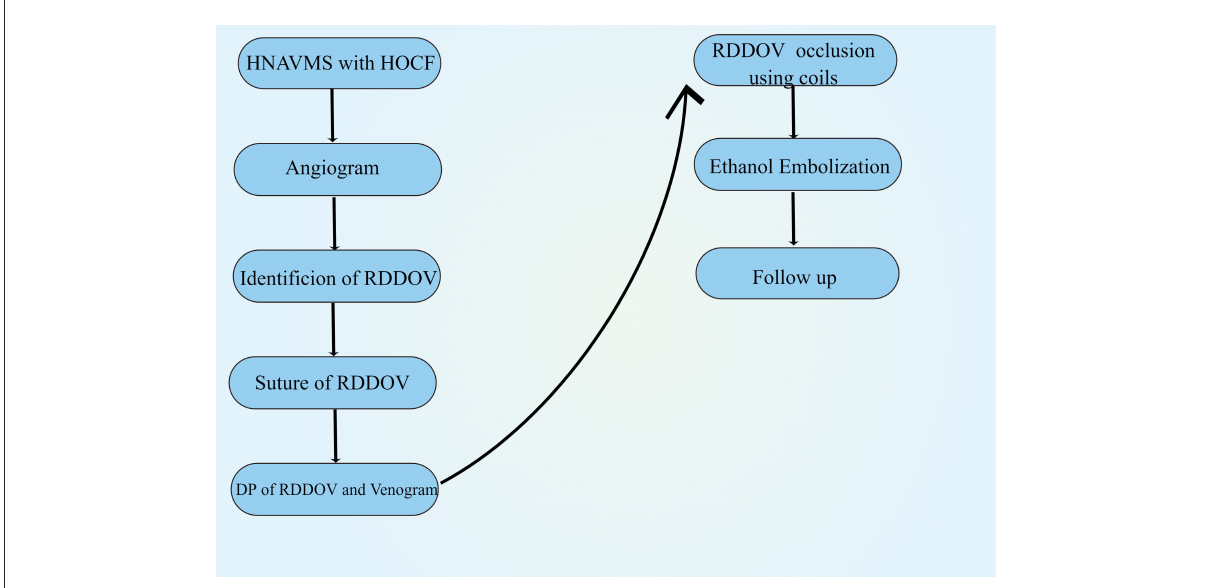
FIGURE2 Schematic depiction of the treatment of head and neck arteriovenous malformations with associated high-output cardiac failure. HNAVMs = head and neck arteriovenous malformations; HOCF, high-output cardiac failure; RDDOV, remarkably dilated dominant drainage vein.